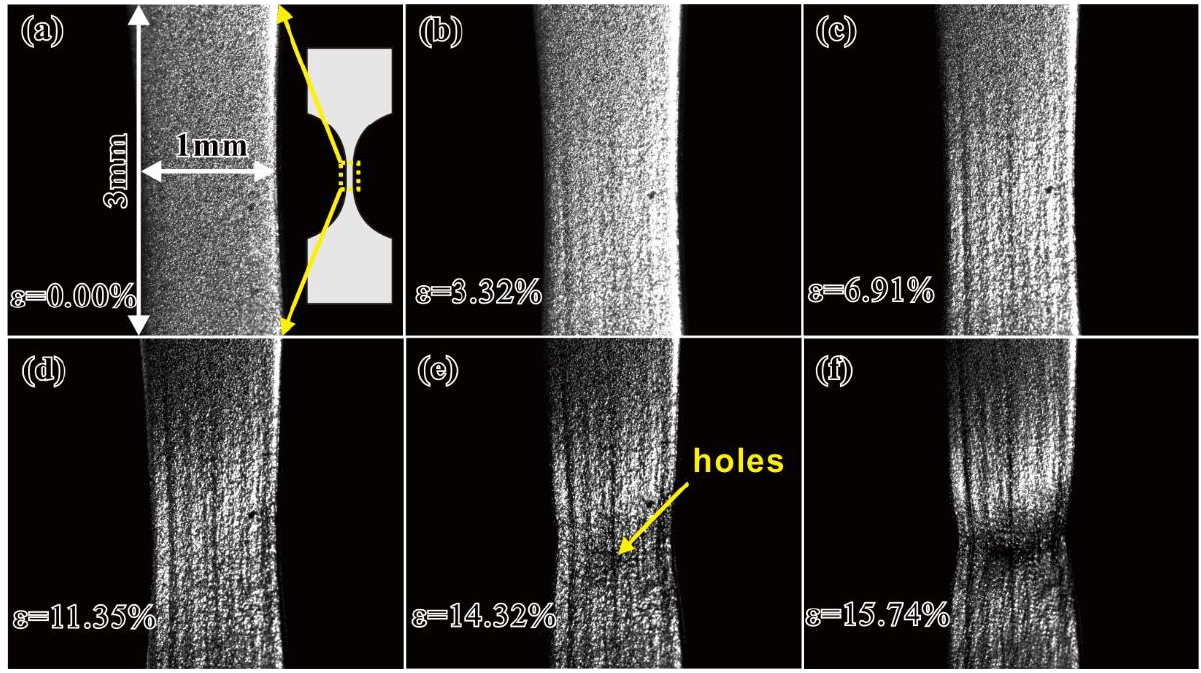
Figure 3. Deformation evolution at the surface of the specimen subjected to different strains from ( a – f ) during tensile loading.